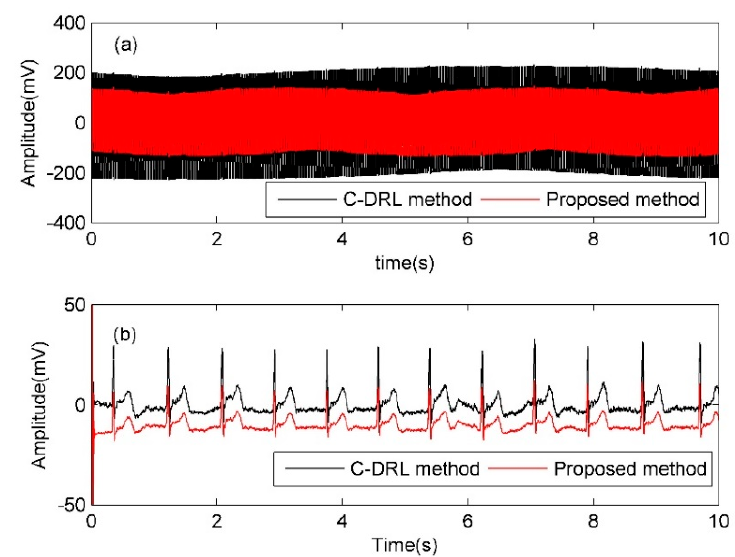
Figure 13. Simultaneous measurement results of human chest ECG acquisition with interface impedance mismatch under static condition, ( a ) time-domain waveform of original signal, ( b ) ECG signal processed by software notch.